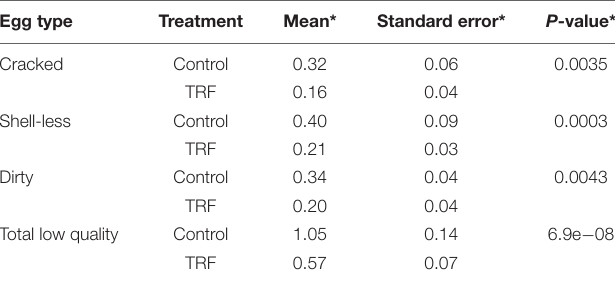
TABLE 5 | Effect of the TRF on the proportion of low-quality